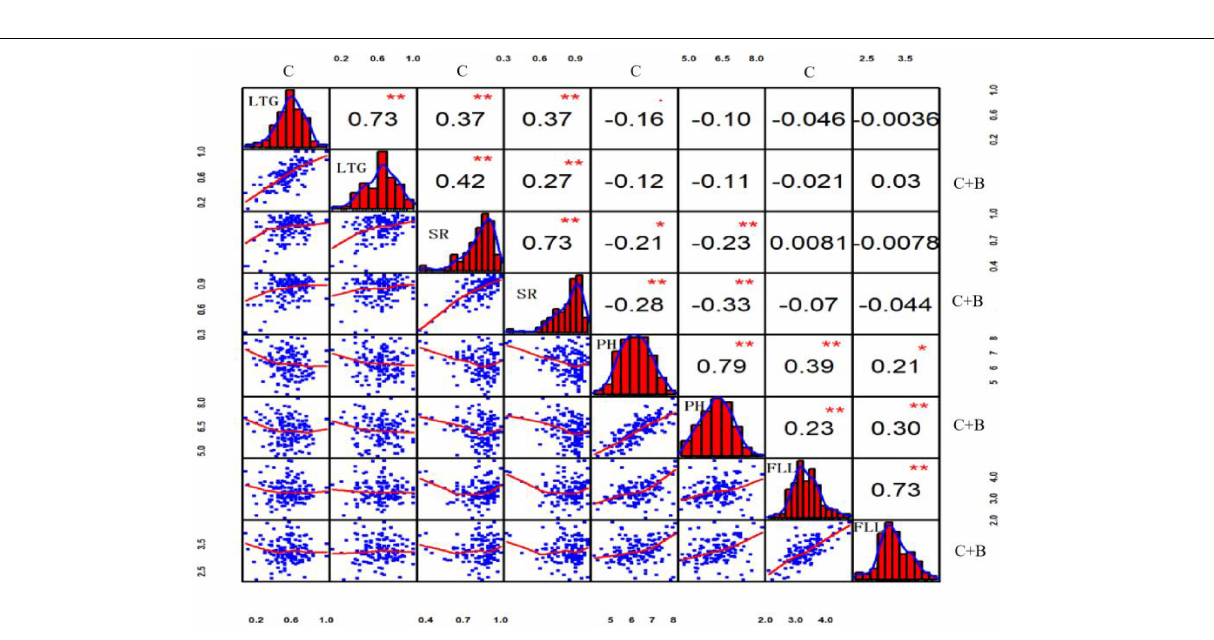
Frontiers in Plant Science |